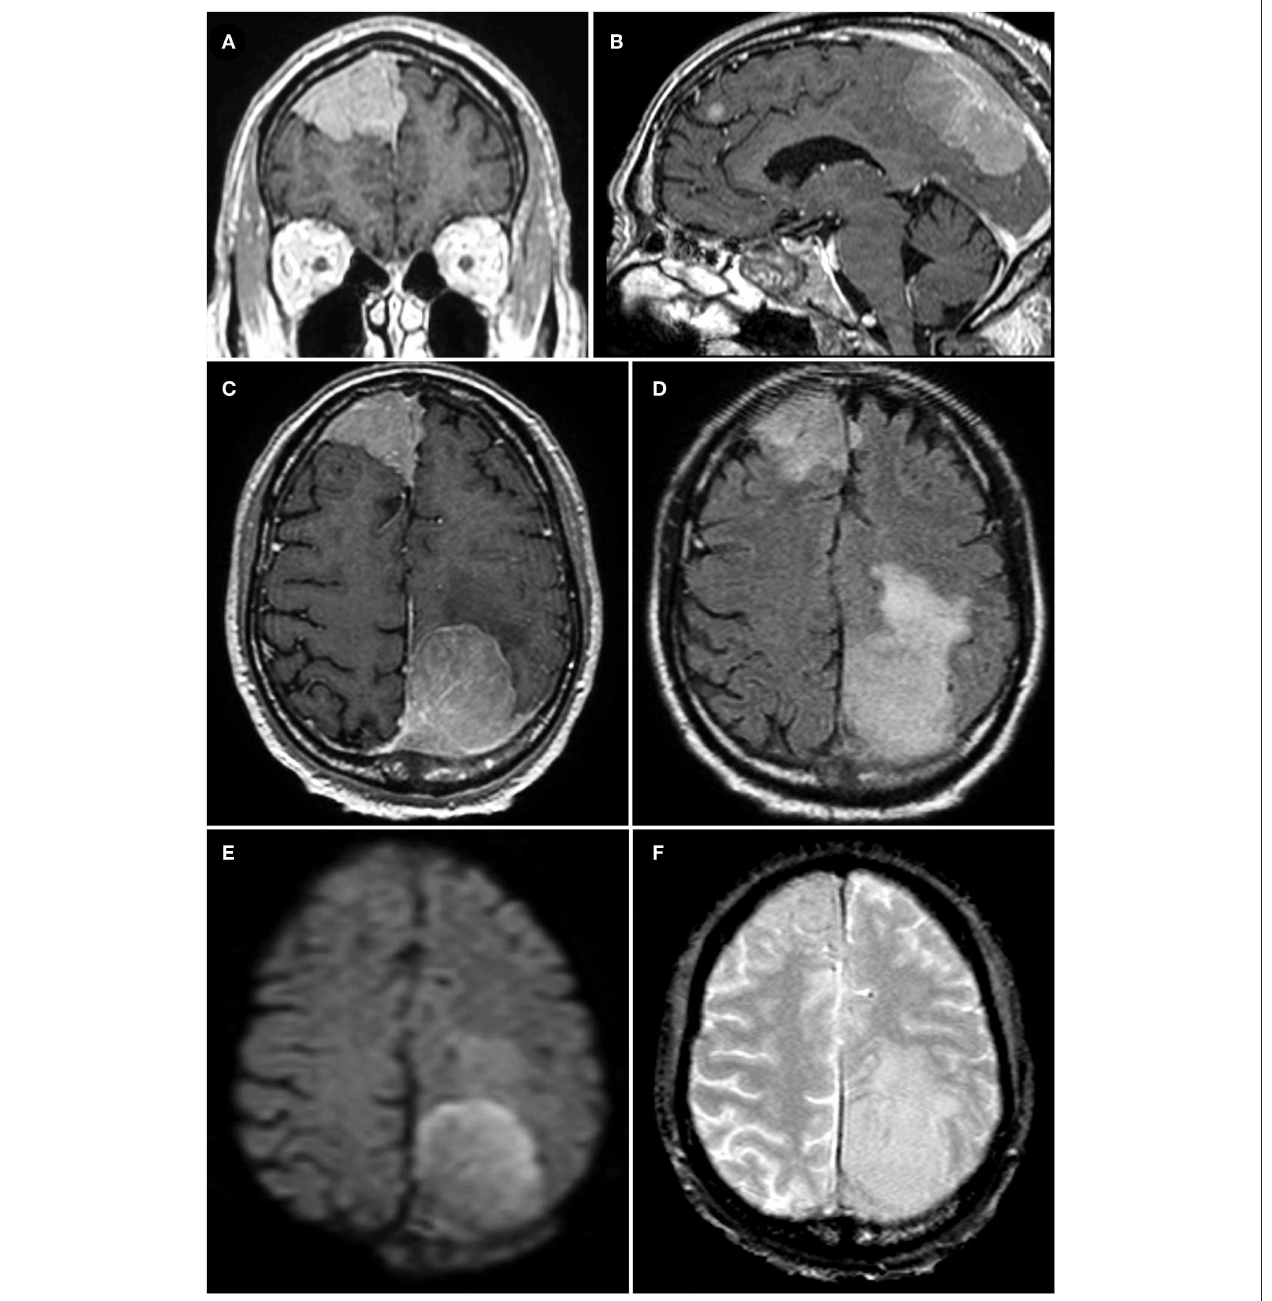
FIGURE 1 | (A–C) Coronal, midsagittal, and axial T1-weighted post-contrast MRI images of the patient’s two parasagittal, enhancing, extradural lesions; both lesions are seen to invade the superior sagittal sinus, particularly the left parasagittal parietal lesion in (B) which also shows evidence of osseous extension. (D) Axial T2-FLAIR-weighted sequence showing extensive peri-lesional vasogenic edema of both the right and left parasagittal lesions, worse on the left. (E) Diffusion-weighted imaging demonstrating evidence of diffusion restriction within the larger, left parasagittal parietal lesion reflecting high cellular density in the tumor (later determined to be a WHO grade II atypical meningioma). (F) Gradient echo (GRE) sequence showing sparsely scattered areas of signal dropout indicative of calcifications, particularly in the right frontal lesion, but no evidence of hemosiderin deposits or other evidence of intratumoral hemorrhage in either lesion.